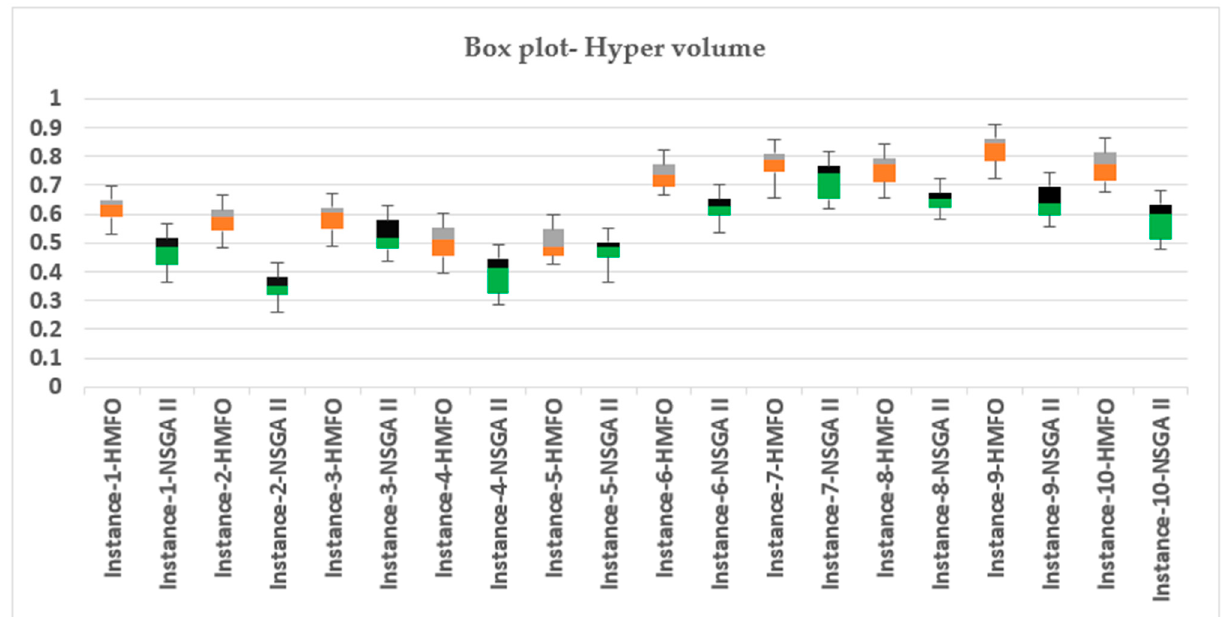
Figure 18. Comparison of HMFO and NSGA-II with Hyper-Volume (HV) results for all the 10 instances of problems.